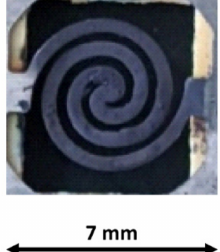
Figure 6. A picture of the PreHG after the deposition of the adsorbent material on its